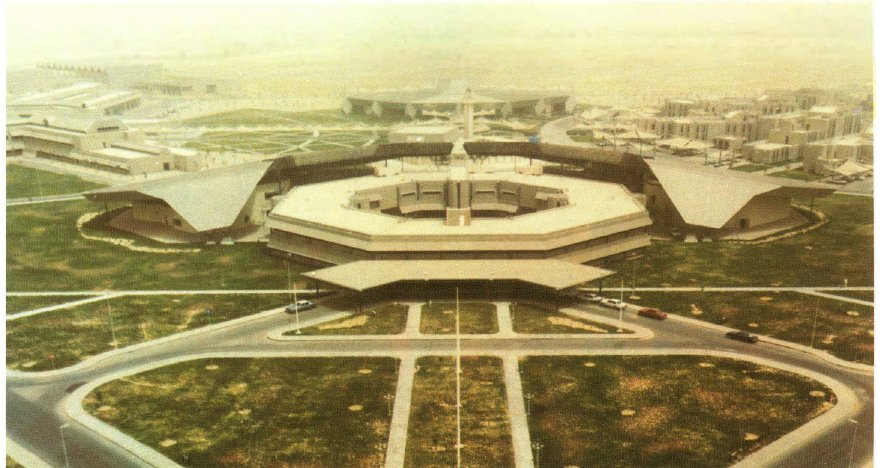
Fig. 8 Human Resources Develop- ment Institute at Jubail shows the octagonal administrative center in foreground, student housing at right, and training wings at left. Source: The Royal Commission for Jubail and Yanbu, 15 Years of Accom- plishments (Riyadh: the Royal Commission,